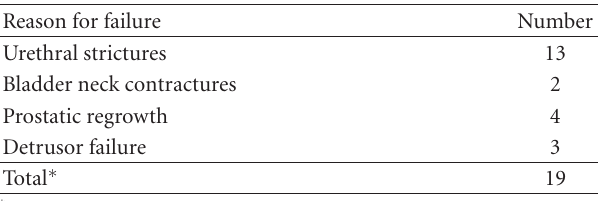
Table 1: Treatment failure